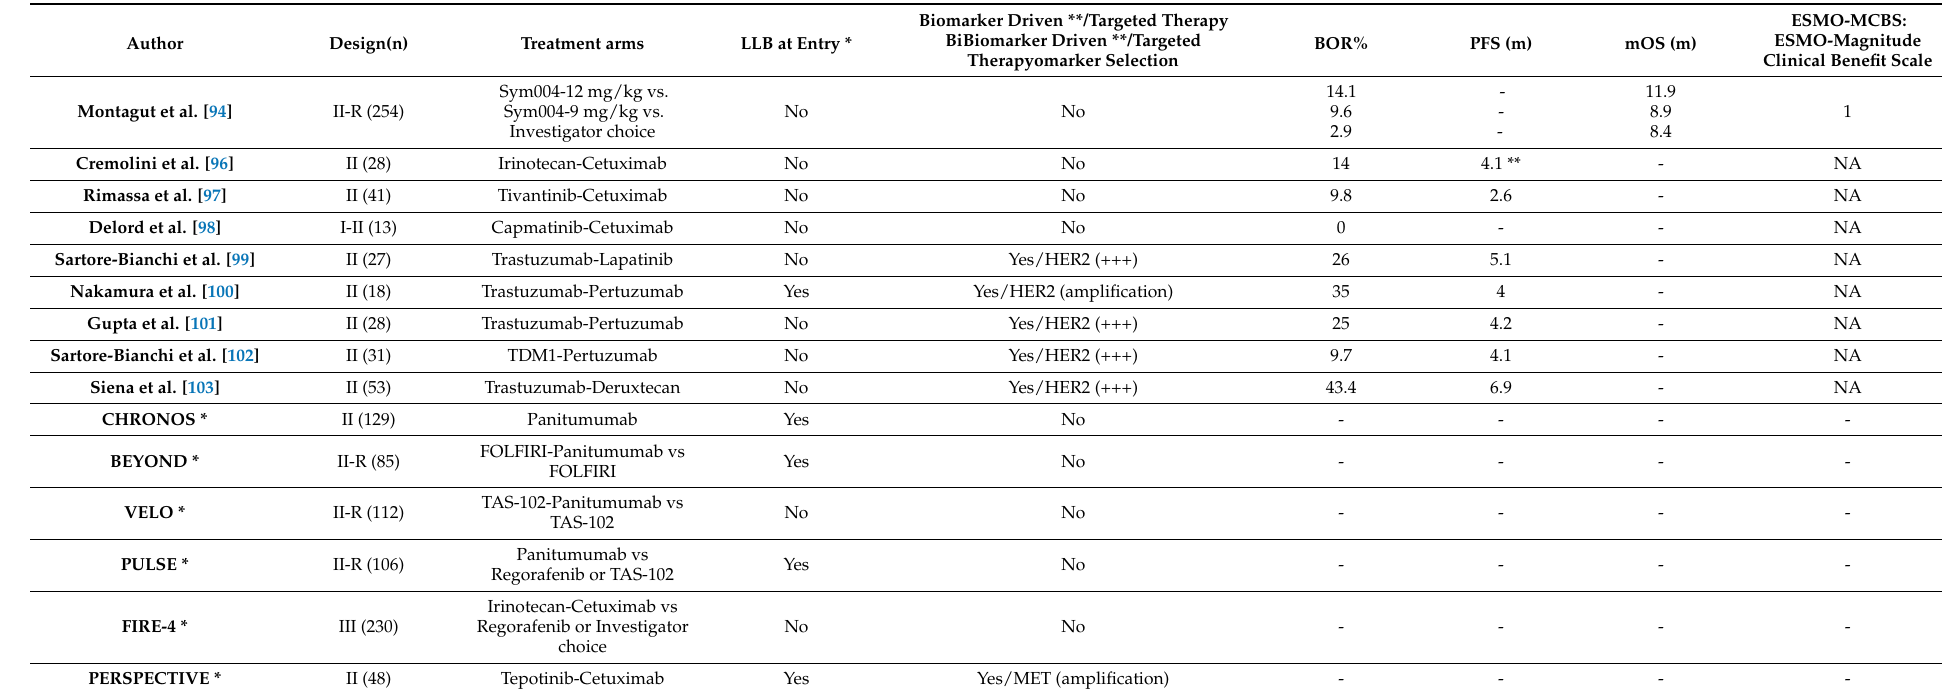
Table 2. New strategies in 2WT mCRC patients after anti-EGFR